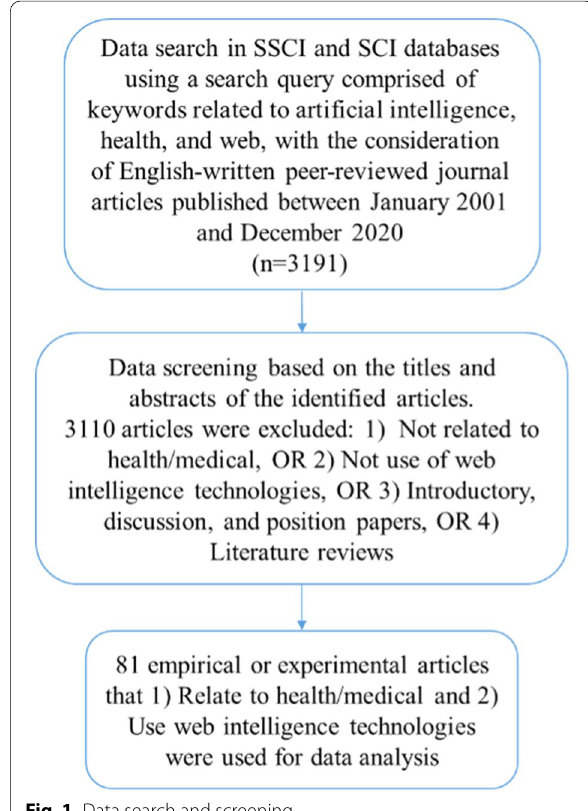
Fig. 1 Data search and screening